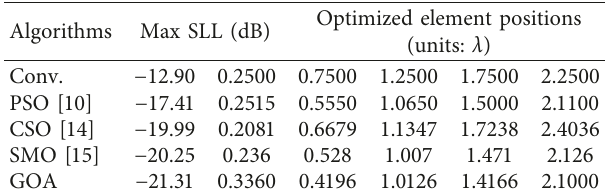
Figure 5: Array factors of 10-element linear array for example 1. Table 1: The maximum SLL of linear array and the location of each element after optimization.